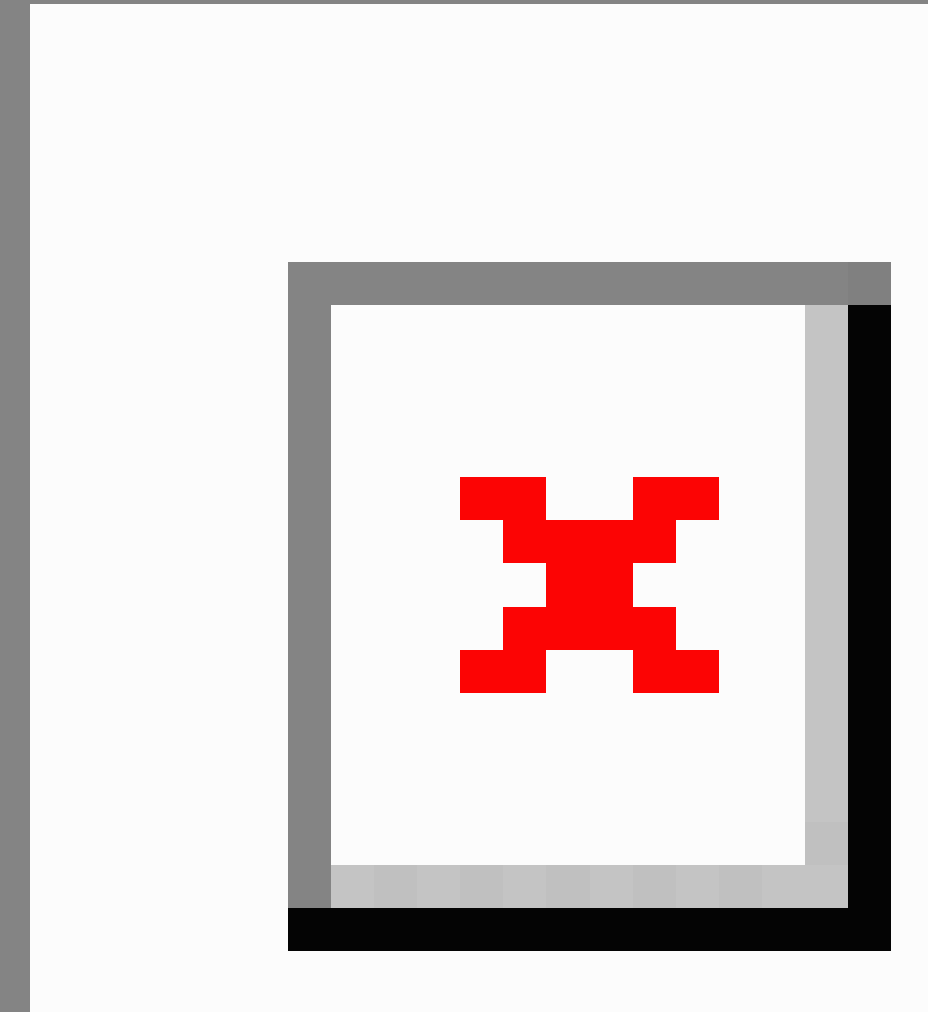
Figure 1. Article selection